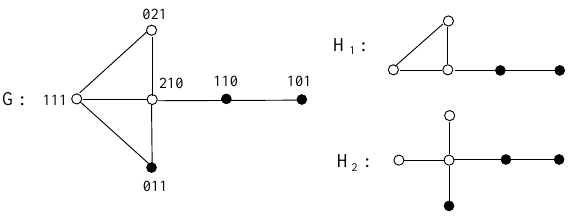
Figure 1: Two subgraphs of an ID-graph G .